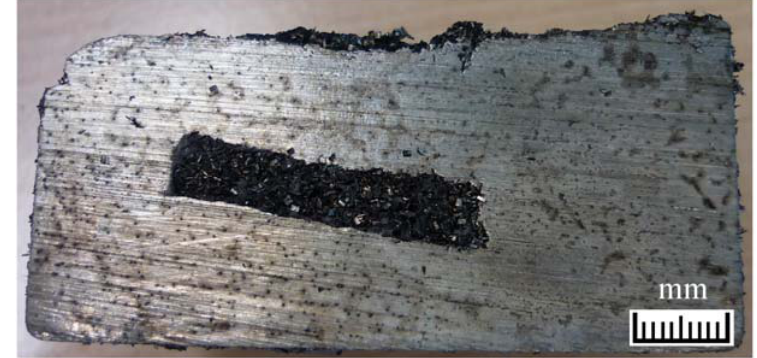
Figure 9. Central aluminium core covered with AM60B.